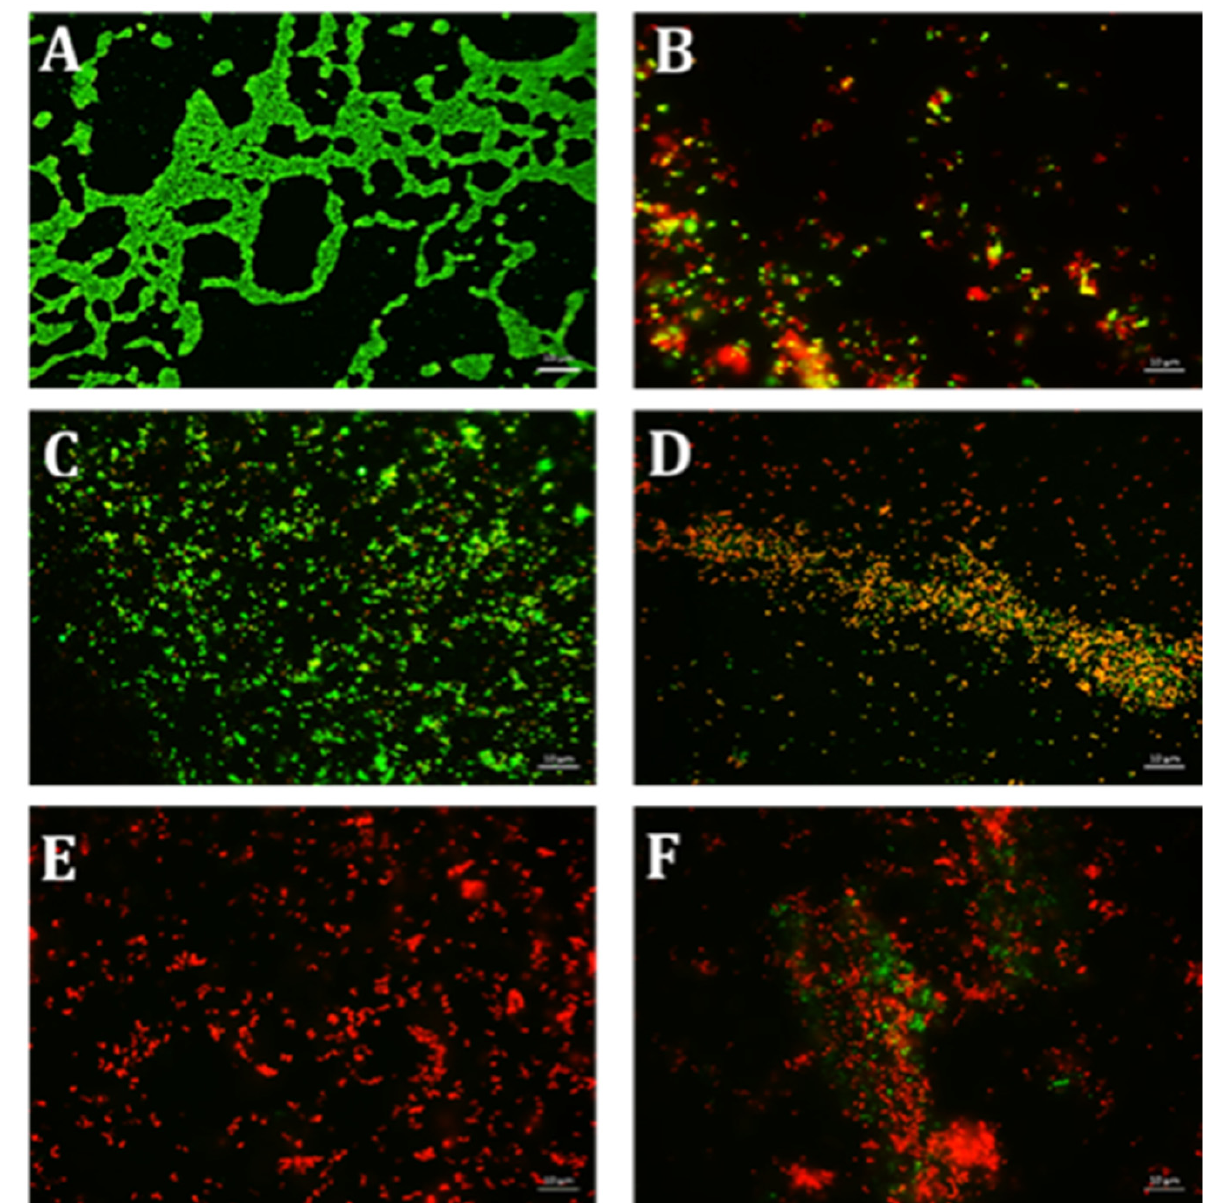
Figure 8. Fluorescence microscopic observation of cell viability on S. aureus biofilm formation. TE: tetracycline; ES: EGCG-S. Scale bar = 10 µ m. ( A ) Control, ( B ) TE15, ( C ) ES100, ( D ) ES200, ( E ) TE15+ES200, and ( F ) TE15+ES250. The results indicated that TE15+ES200 severely affected the viability of the cells.